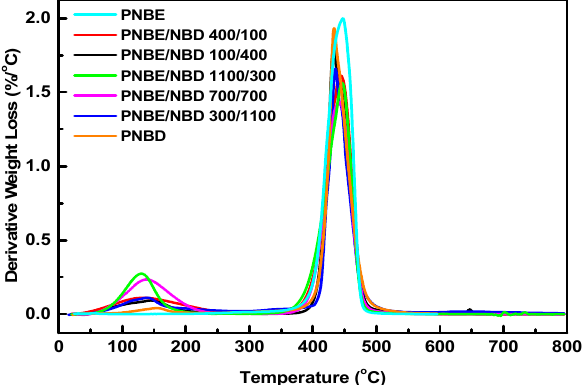
Figure 5. Derivative weight loss (%/°C) vs. temperature (°C) for all samples, as indicated.